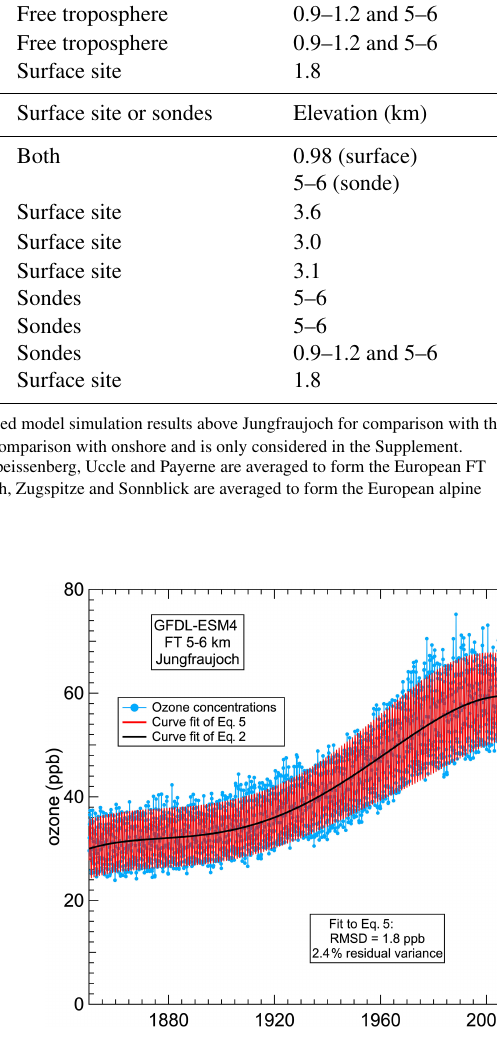
Figure 2. Blue points indicate the same example time series of sim- ulated monthly mean ozone concentrations shown in Fig. 1. The black and red curves indicate a fit to the 5-parameter long-term change in Eq. (2) and a fit to the full 15-parameter Eq. (5), respec-